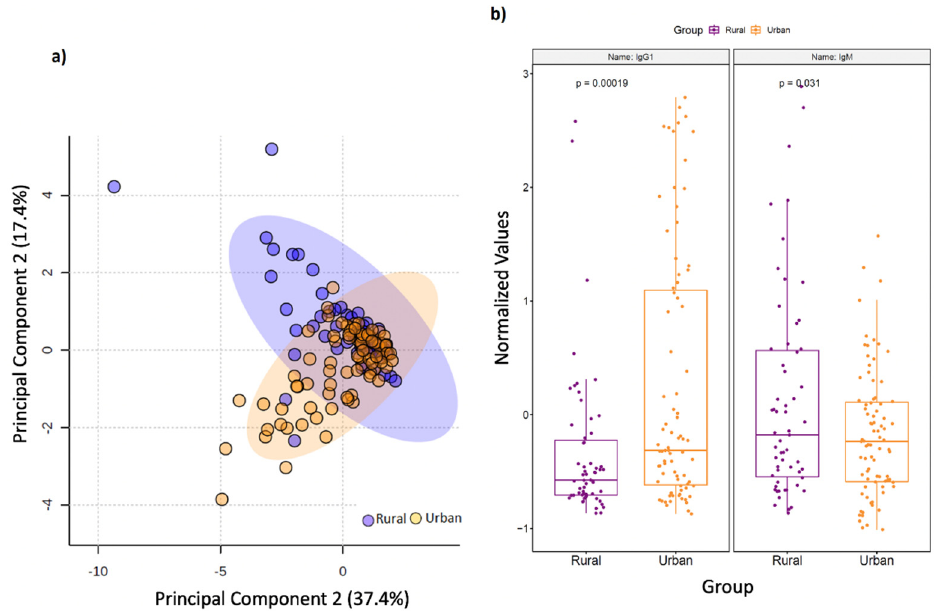
Figure 2. Serum immunoglobulin levels vary by geography. ( a ) Principal component analysis (PCA) score plot on the selected features demonstrates a clear separation in serum multi-isotype antibody responses in terms of geographic setting of sampled population. Dots represent patients and are coloured according to the subject cohort. Ellipse represents 95% confidence. Results are plotted according to the Principal component-1 (PC1) and Principal component-2 (PC2) scores, with the percent variation of the cohort explained by the respective x and y axess. ( b ) Box plots showing levels of serum IgM and IgG1 antibodies in rural and urban cohorts, respectively.